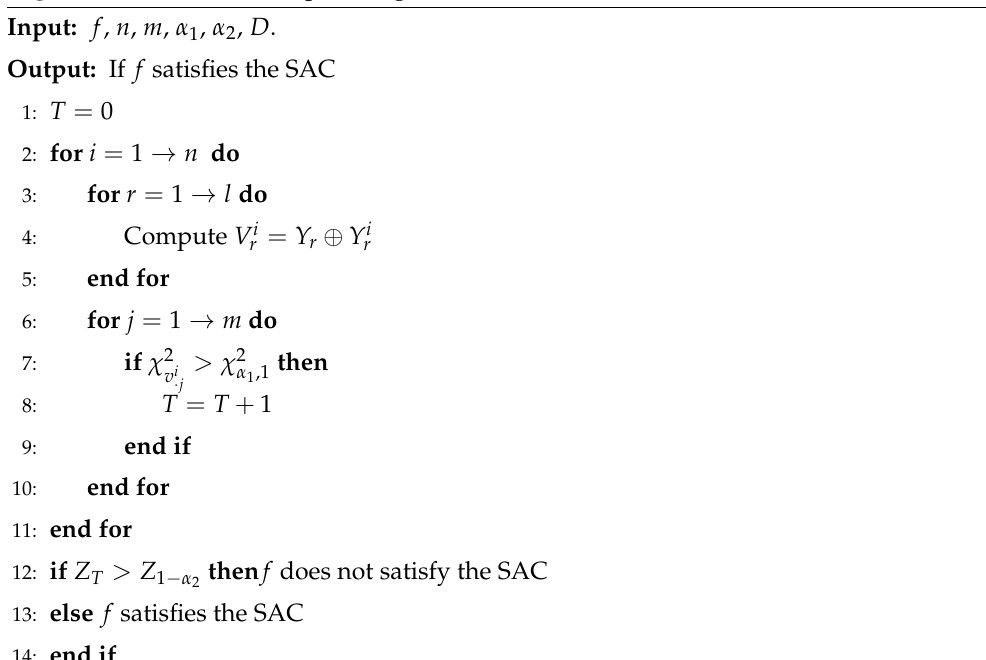
Algorithm 1 SAC stream ciphers